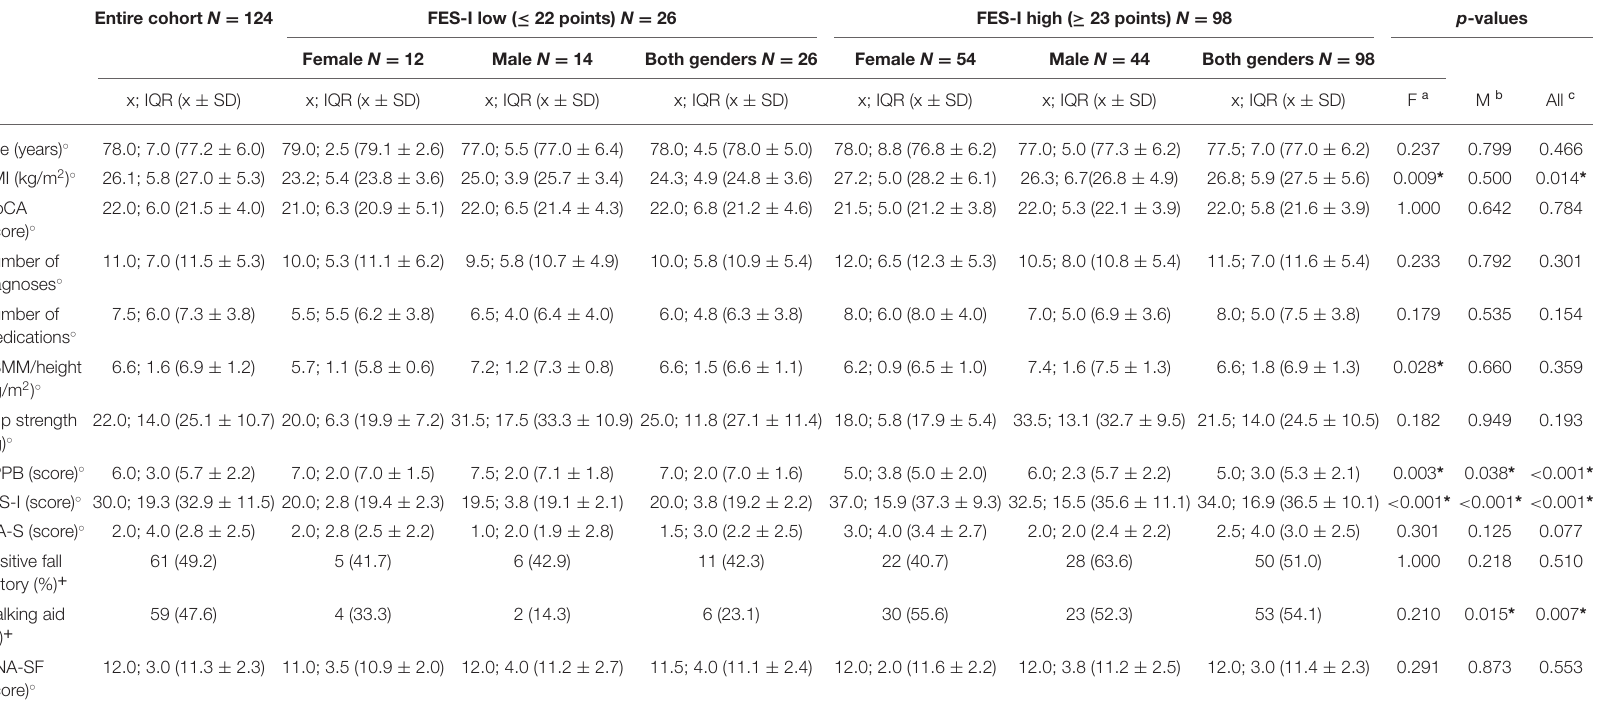
TABLE 1 | Patients’ characteristics and group